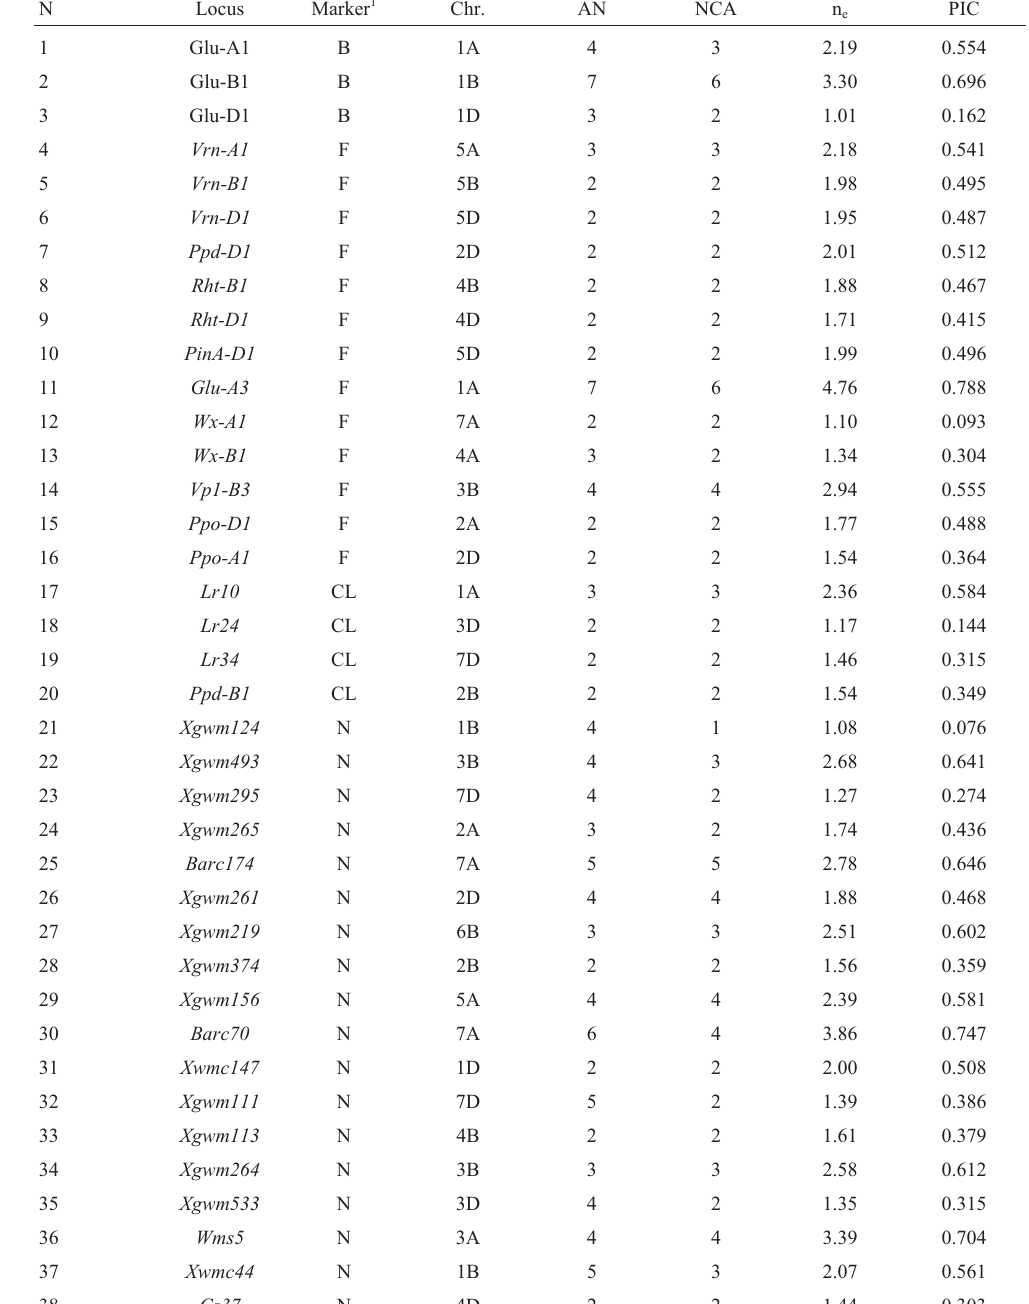
Table 1 - Biochemical and molecular markers used in the study, chromosome location, number of alleles, number of common alleles, effective allele number and polymorphic information content (for details see Supplementary Tables S2 and S3). N Locus Marker 1